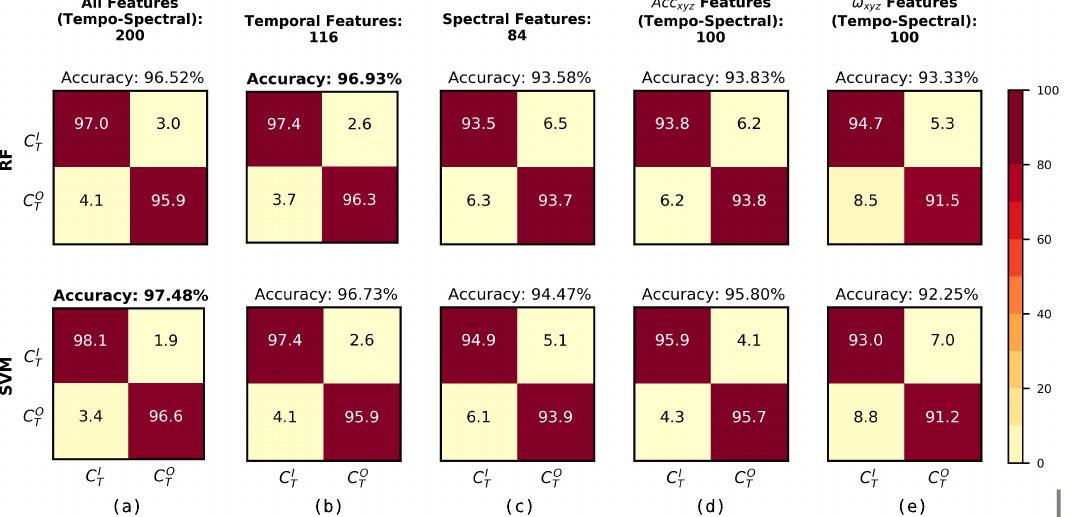
= indoor (carpet, concrete, tiles) and T